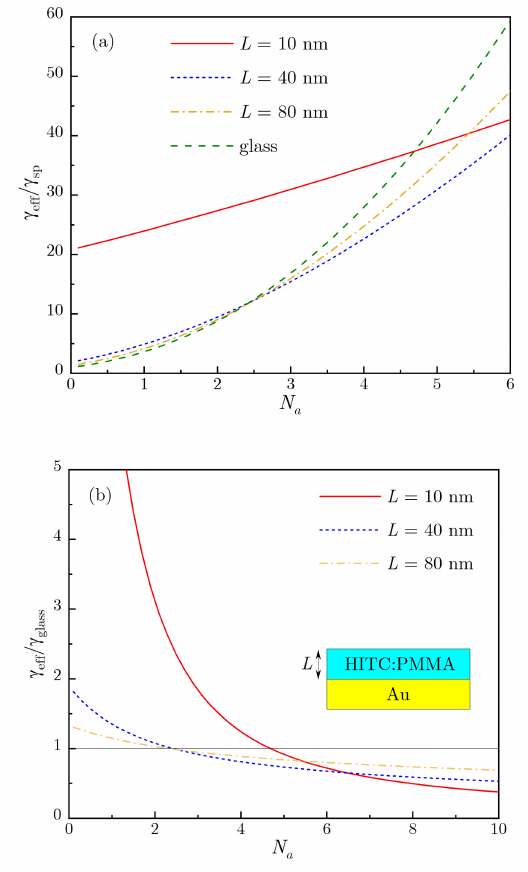
Figure 10. ( a ) Calculated e ff ective decay rate, normalized by free-space spontaneous decay rate, plotted against acceptor concentration for several HITC:PMMA film thicknesses. ( b ) The ratio of e ff ective decay rates for HITC:PMMA film on top of metal and of glass substrates is plotted vs. concentration for several film